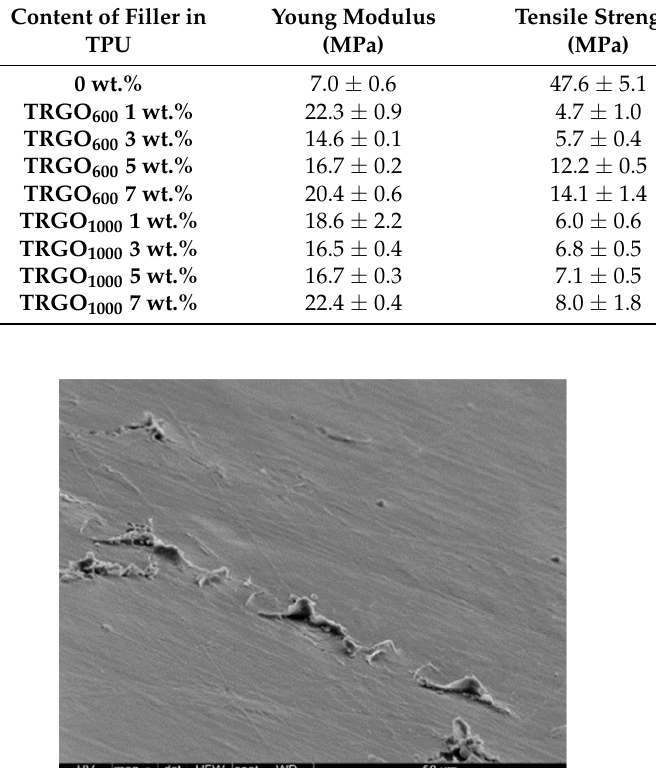
Table 4. Mechanical properties of TPU and TPU/TRGO nanocomposites.